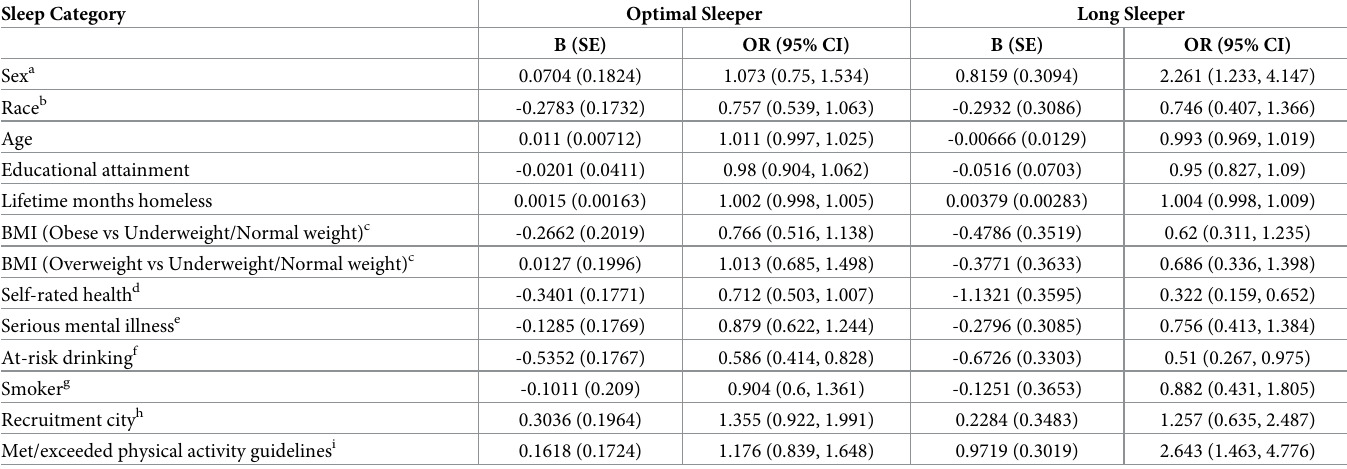
Table 4. Relation between sleep duration and meeting/exceeding the physical activity guidelines (N =